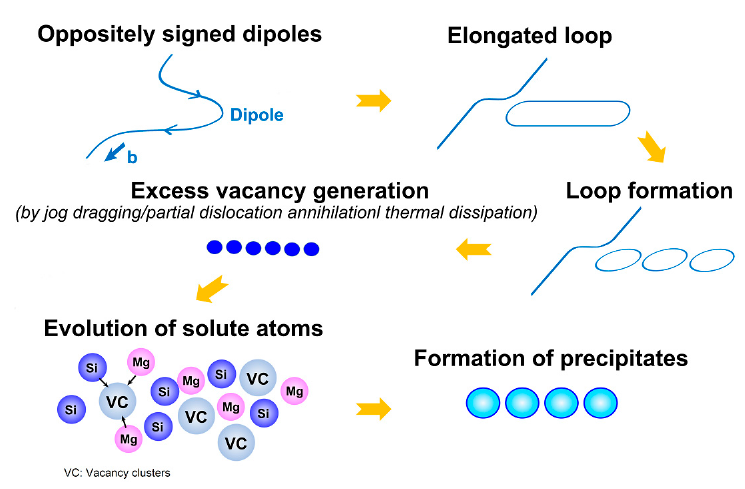
Figure 10. Schematic representation of formation of precipitates during cyclic deformation.